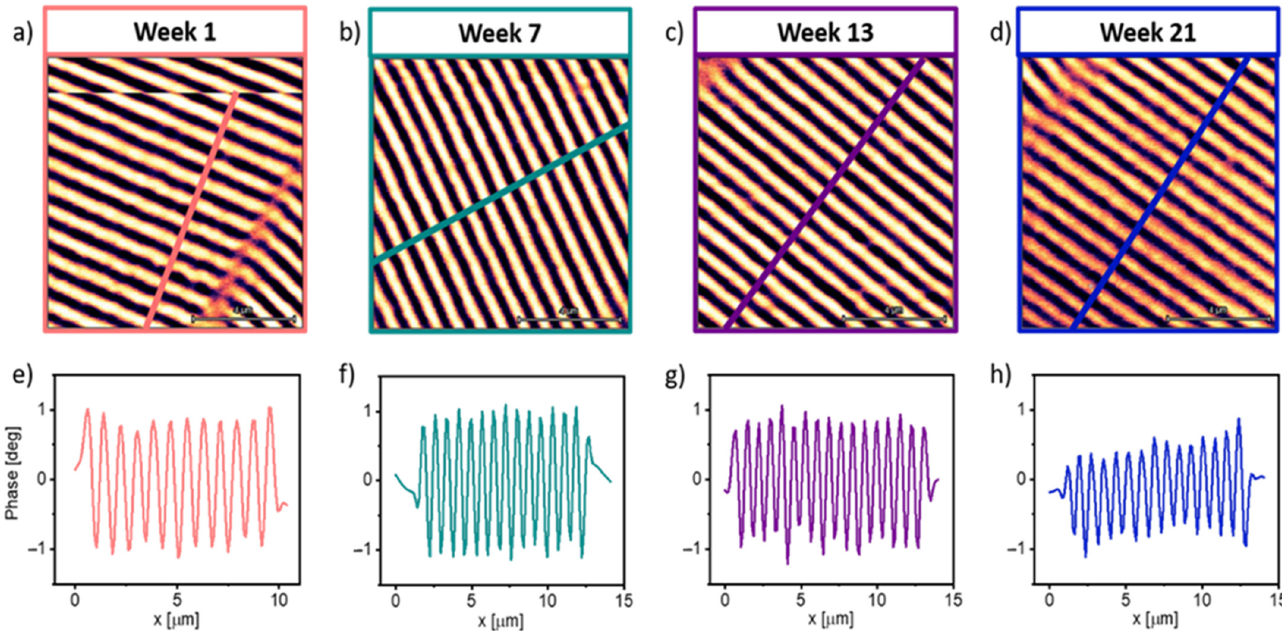
Figure 5. MFM images ( a – d ) of the magnetic storage tape reference sample obtained by tip 10 and their corresponding line profiles of magnetic contrast ( e – h ). These measurements were carried out over a period of 21 weeks. After 21 weeks it is observed that the magnetic signal is still high. In the profiles of week 1 ( a ), week 7 ( b ) and week 13 ( c ) it is observed that the magnetic domain contrasts have an amplitude of ~1°, and in the profile of week 21 a lower contrast is observed with greater variation.